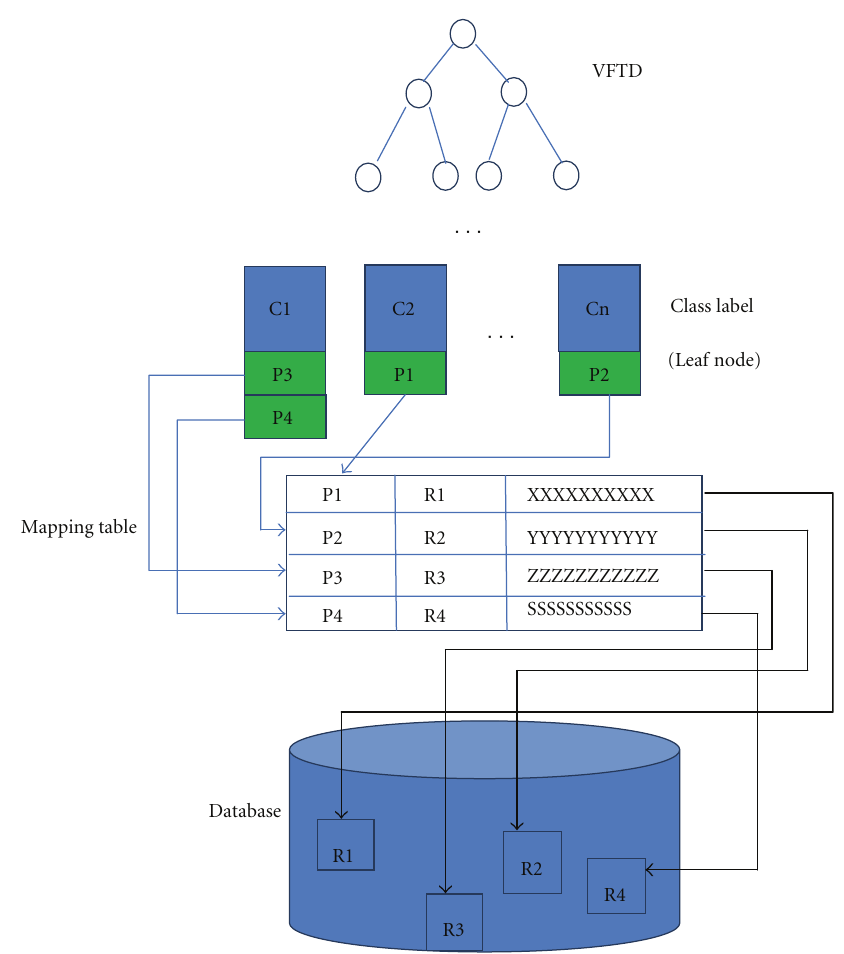
Figure 6: How mapping works in the initial training stage for VFDT.